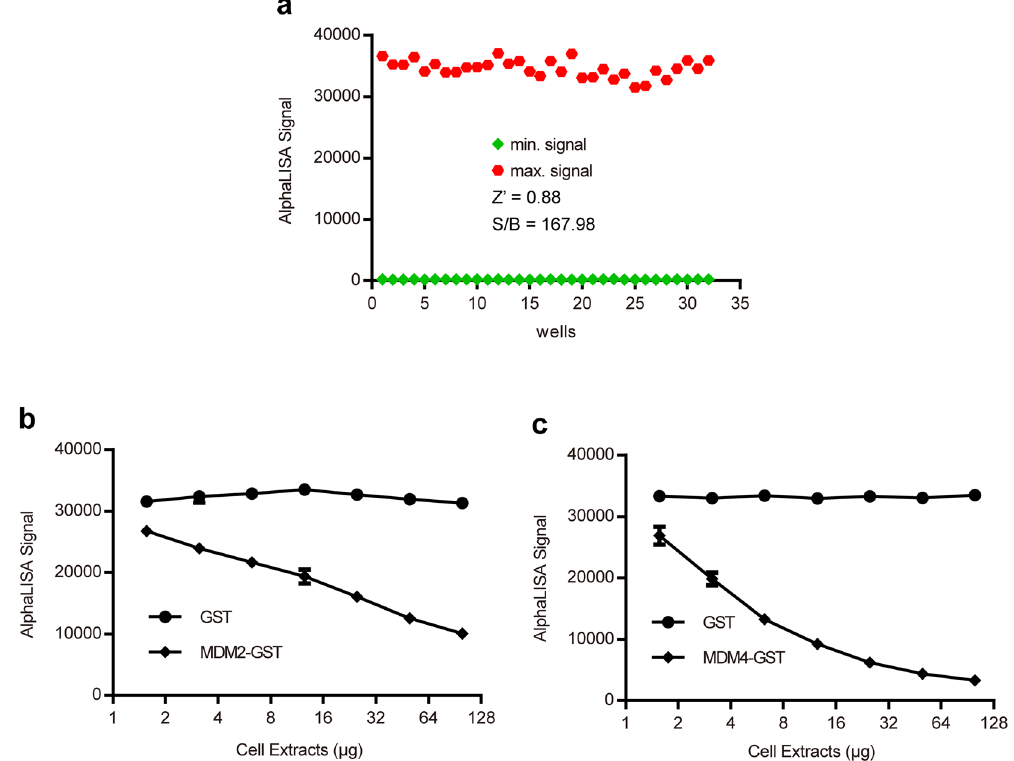
Figure 3. AlphaLISA assay development to detect the interaction between p53 TAD and its ligands in HTS format and validation of the assay. ( a ) Robustness of the AlphaLISA assay. In order to determine Z ′ -factor, an experiment including 32 positive controls with optimal amount of HEK293T cell extracts (min. signal) and 32 negative controls with same amount of cell extracts containing p53-His (max. signal) was conducted on 96-well plates. ( b , c ) Dose-response curve of cell extracts containing MDM2-GST/MDM4-GST, which compete with anti-p53 antibody for binding to the TAD of